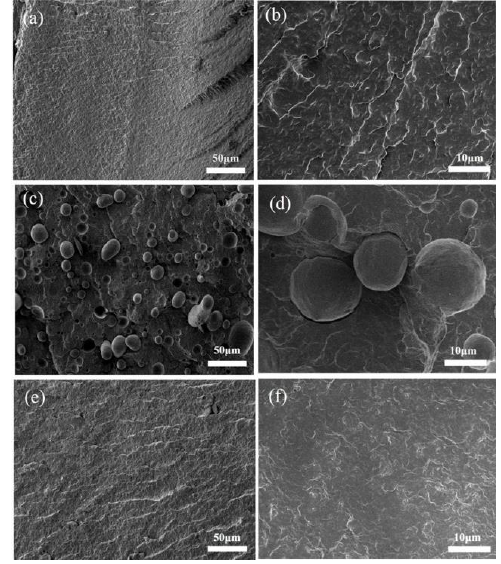
Figure 16. SEM fractographs of different samples: ( a , b ) PA6; ( c , d ) iPB/PA6 blends; ( e , f ) iPB-g-MAH/PA6 blends.